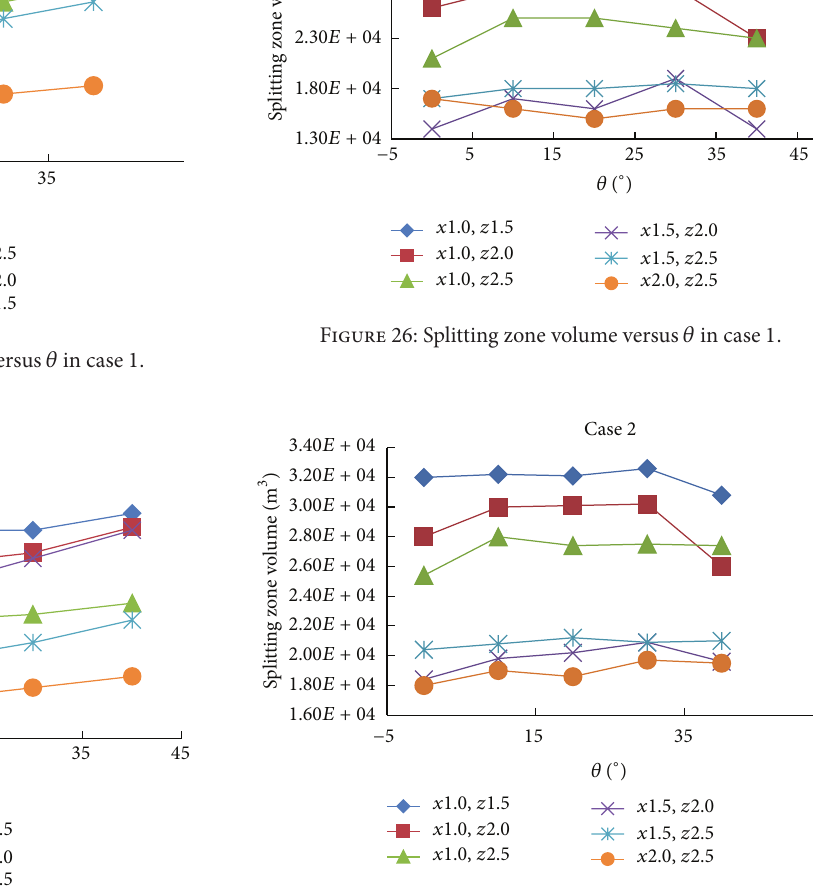
Figure 24: Key point displacement versus 𝜃 in case 2 .